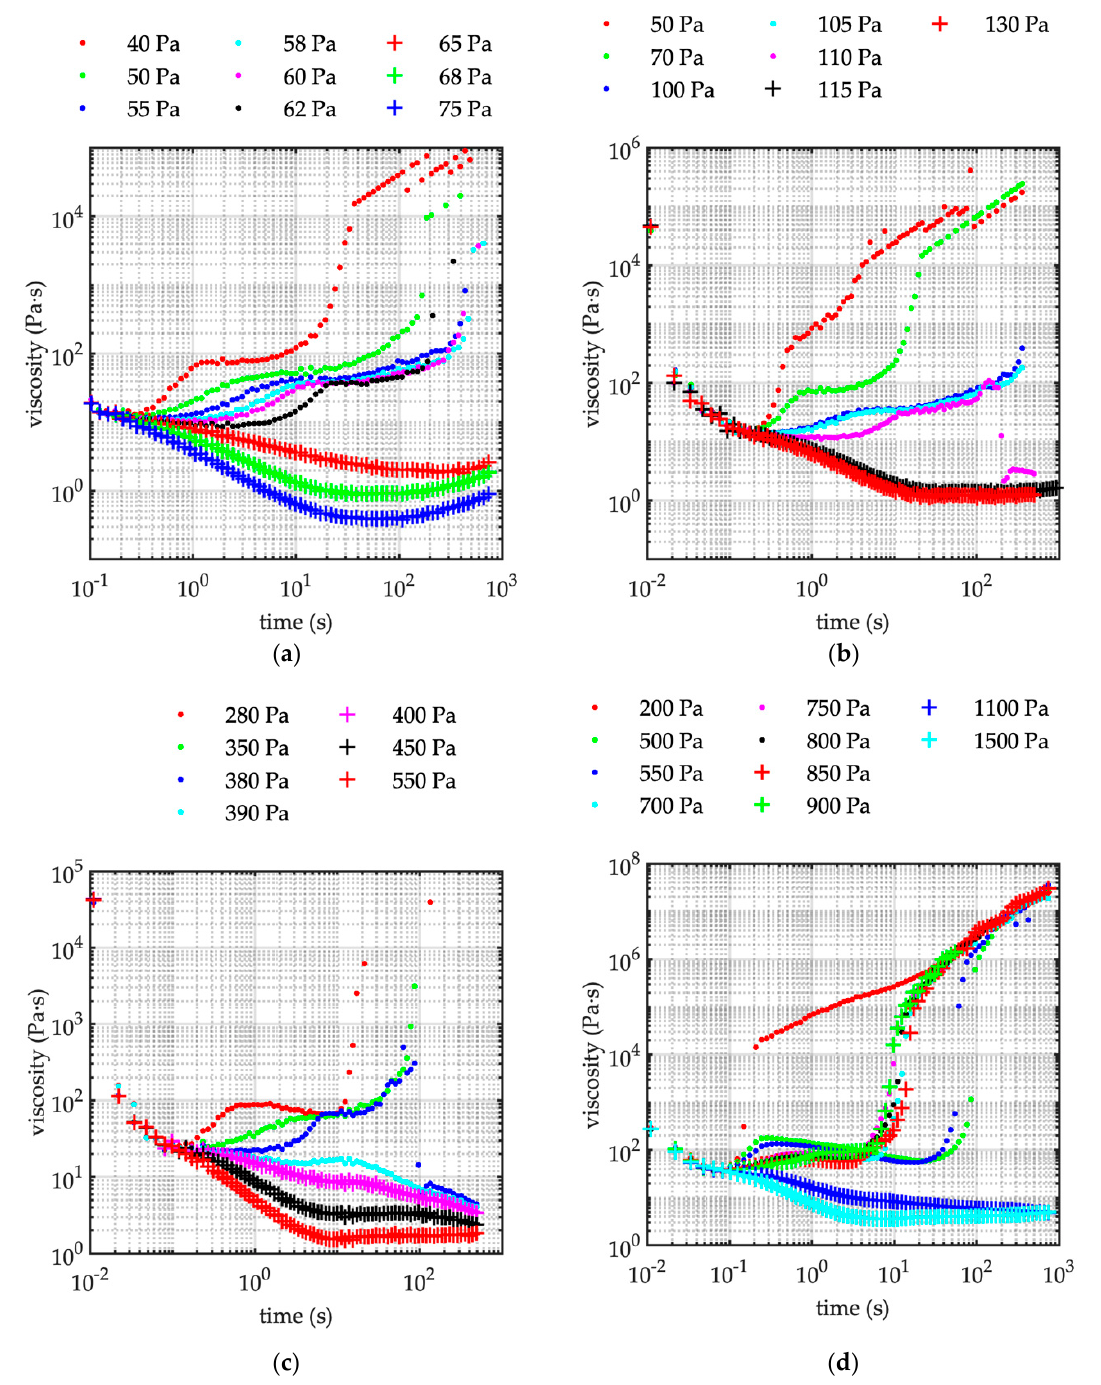
Figure 4. Creep test. The apparent viscosity-time trend during the test. ( a ) Sediment concentration C = 50%. Runs C87–C95 (see Table 2) corresponding to the increasing applied shear as it is reported in the legend. ( b ) Sediment concentration C = 52%. Runs C36–C42 (see Table 2) corresponding to the increasing applied shear as it is reported in the legend. ( c ) Sediment concentration C = 56%. Runs C59–C65 corresponding to the increasing applied shear as it is reported in the legend. ( d ) sediment concentration C = 58%. Runs C96–C104 and Run C108 (see Table 2) corresponding to the increasing applied shear as it is reported in the legend.